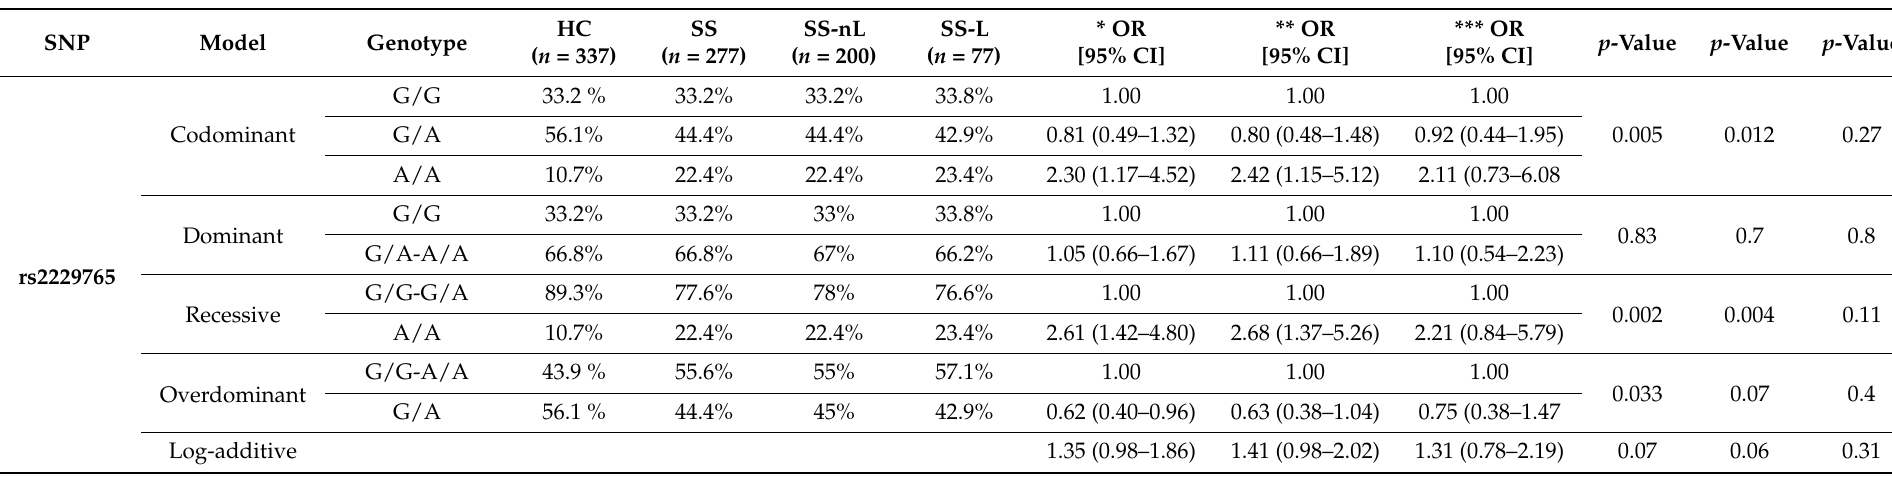
Table 2. Genotypic frequencies of the IGF1R rs2229765 variant in SS patients with or no lymphoma versus HCs after adjustment for age and